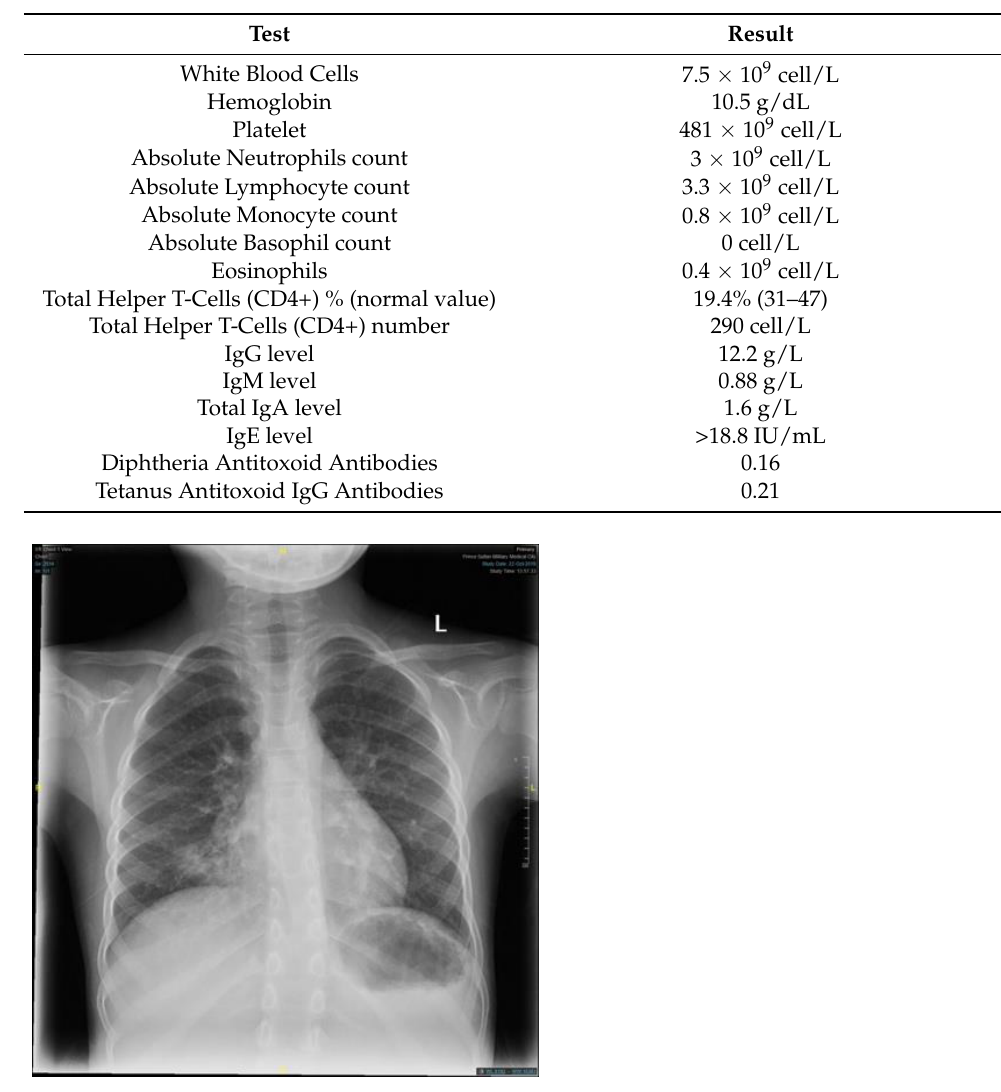
Figure 2. A plain chest X-ray, an anteroposterior film, showing a radioopaque opacity infiltrate seen over the right and left lower zone with mild hyperinflation. (L = Left).